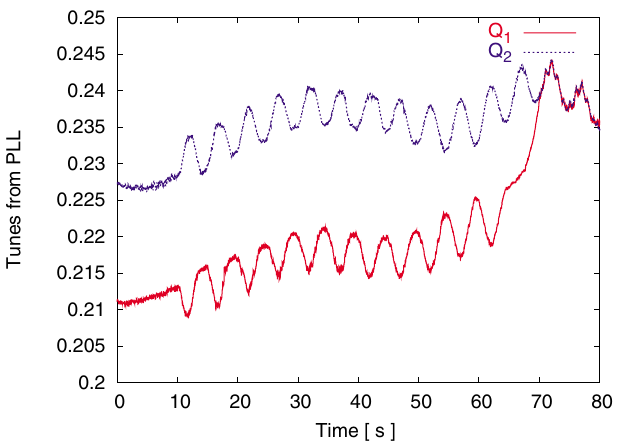
FIG. 6. (Color) An example of measurement on the ramp.